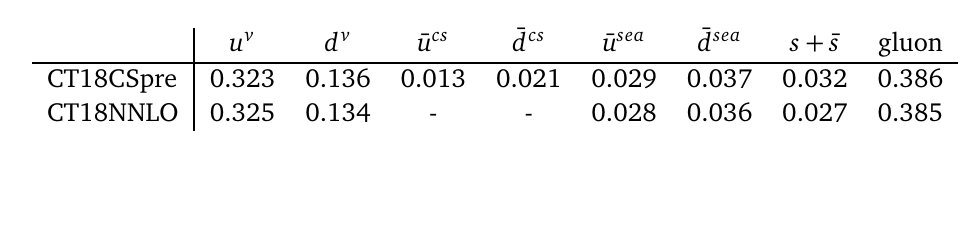
Table 1: The second moments 〈 x 〉 for CT18CSpre and CT18NNLO at 1.3 GeV. Here, we define ¯ q sea ≡ ¯ q cs + ¯ q ds , with q = u or d , and s ≡ s ds for